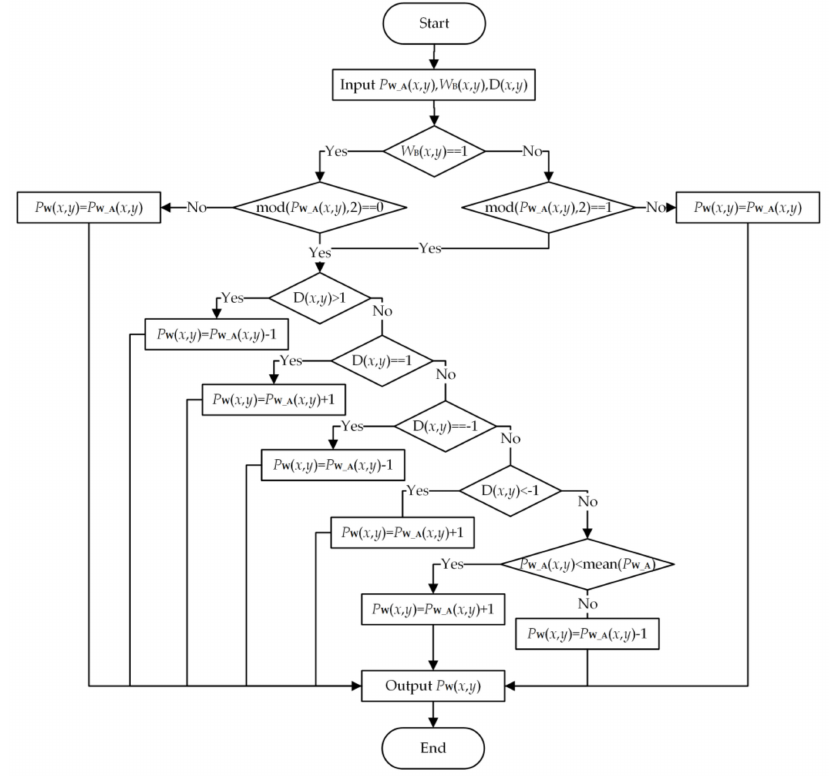
Figure 5. Embedding procedure of one bit of W B